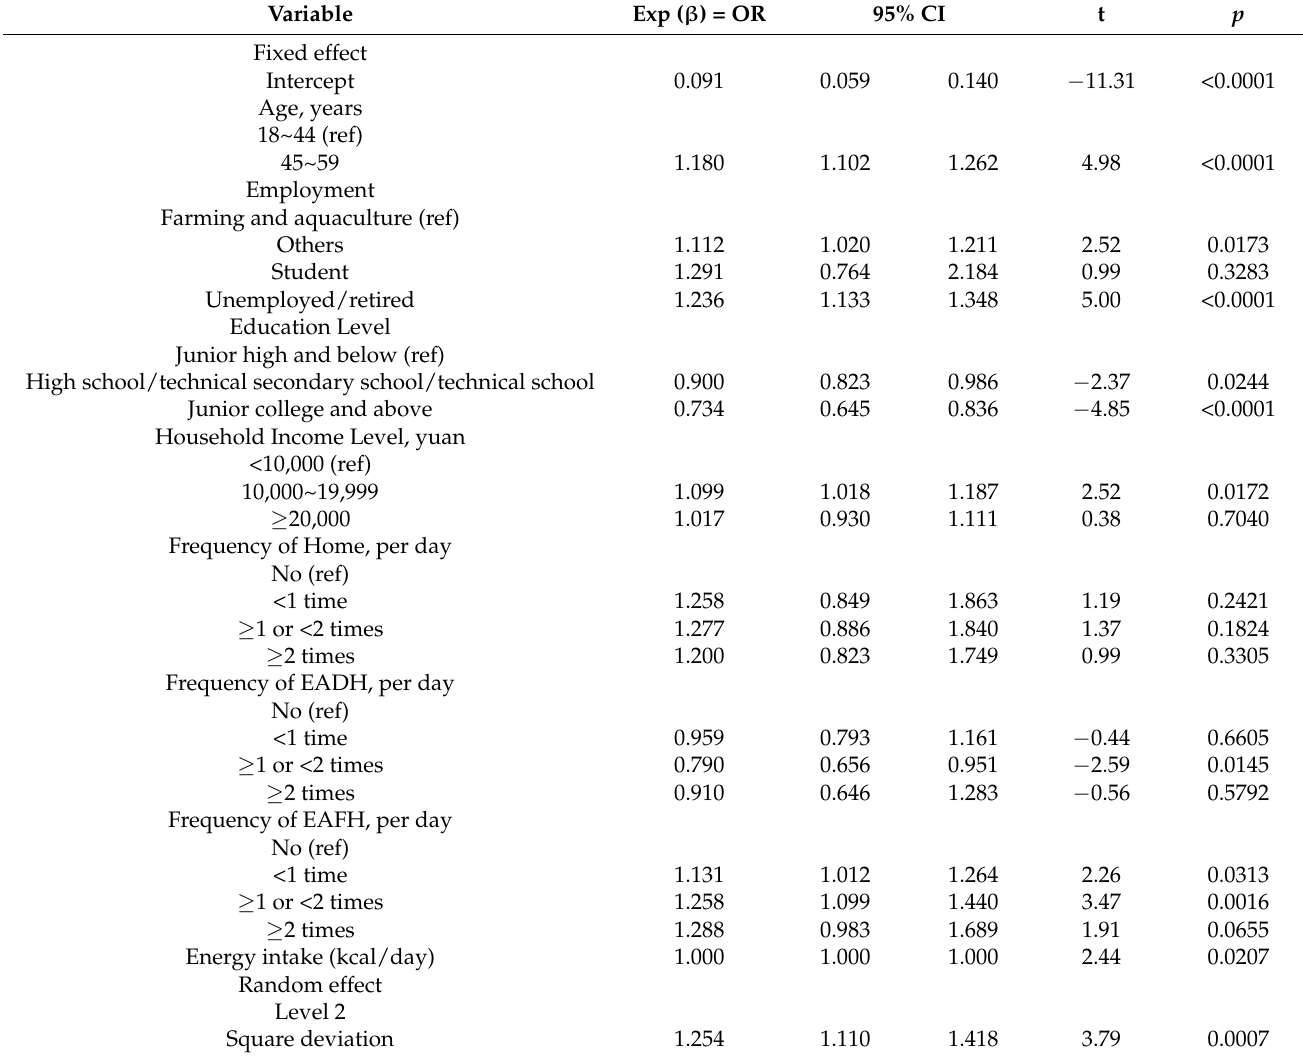
Table 5. The fitting results of the optimized two-level multi-factor logistic prediction